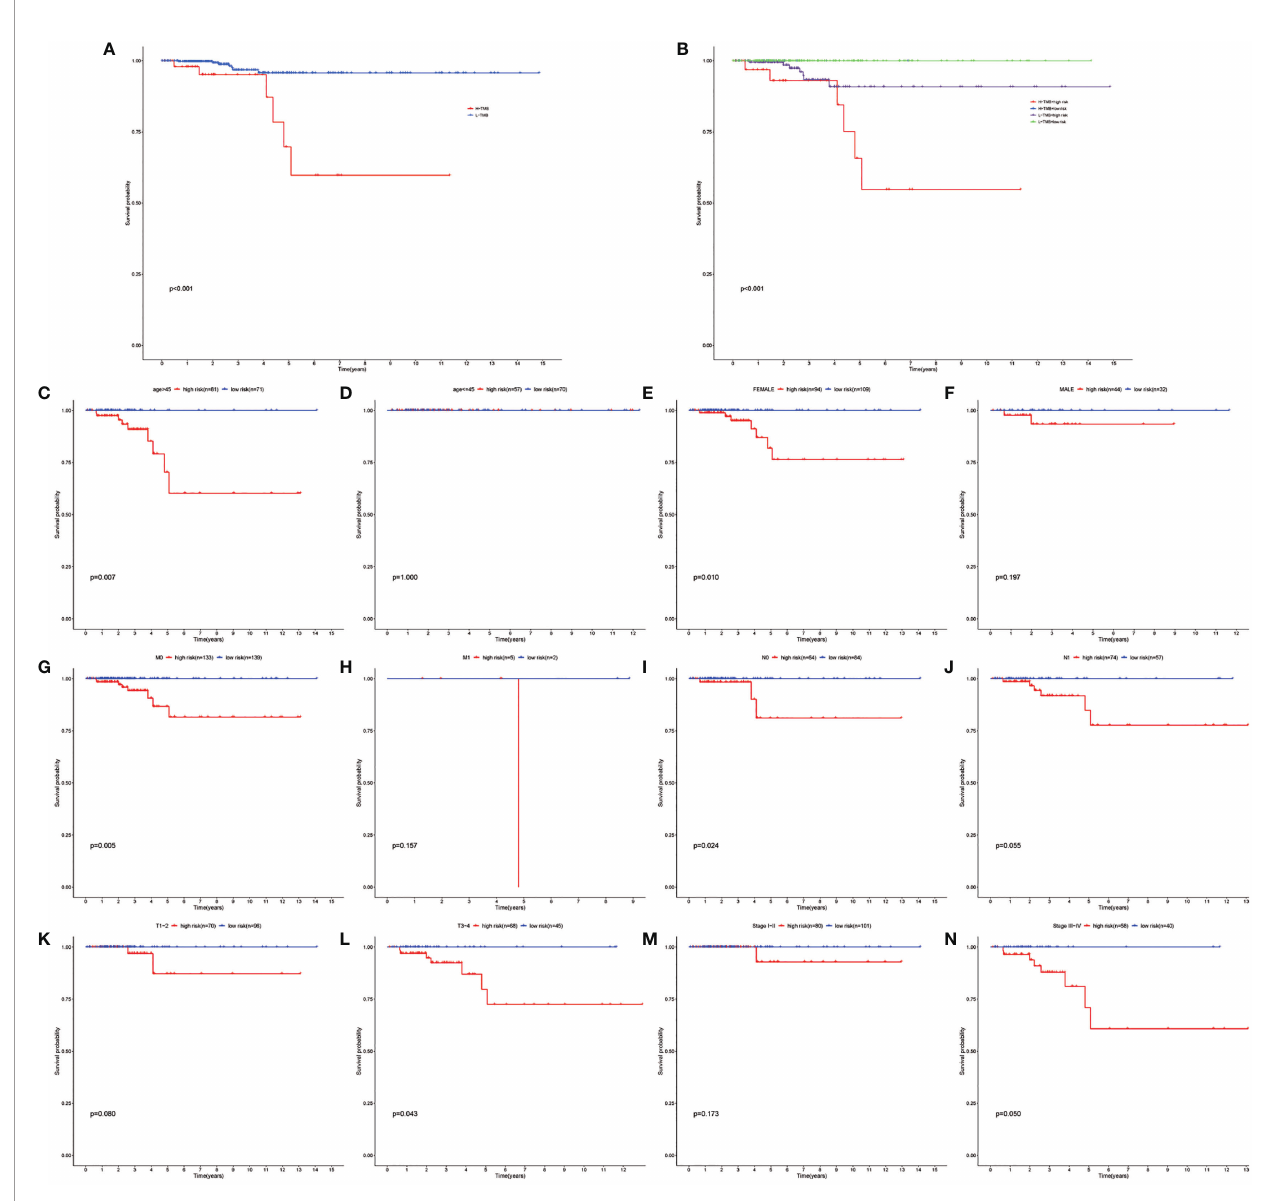
FIGURE 5 | Performing the survival analysis combining TMB with risk strati fi cation. (A) Kaplan – Meier survival analyses of high-TMB and low-TMB papillary thyroid carcinoma (PTC) group. (B) Kaplan – Meier survival analyses of high TMB combined with high risk, high TMB combined with low risk, low TMB combined with high- risk group, and low TMB combined with low-risk group. (C – N) Kaplan – Meier survival analyses of the autophagy-related long noncoding RNA (lncRNA) risk strati fi cation in different